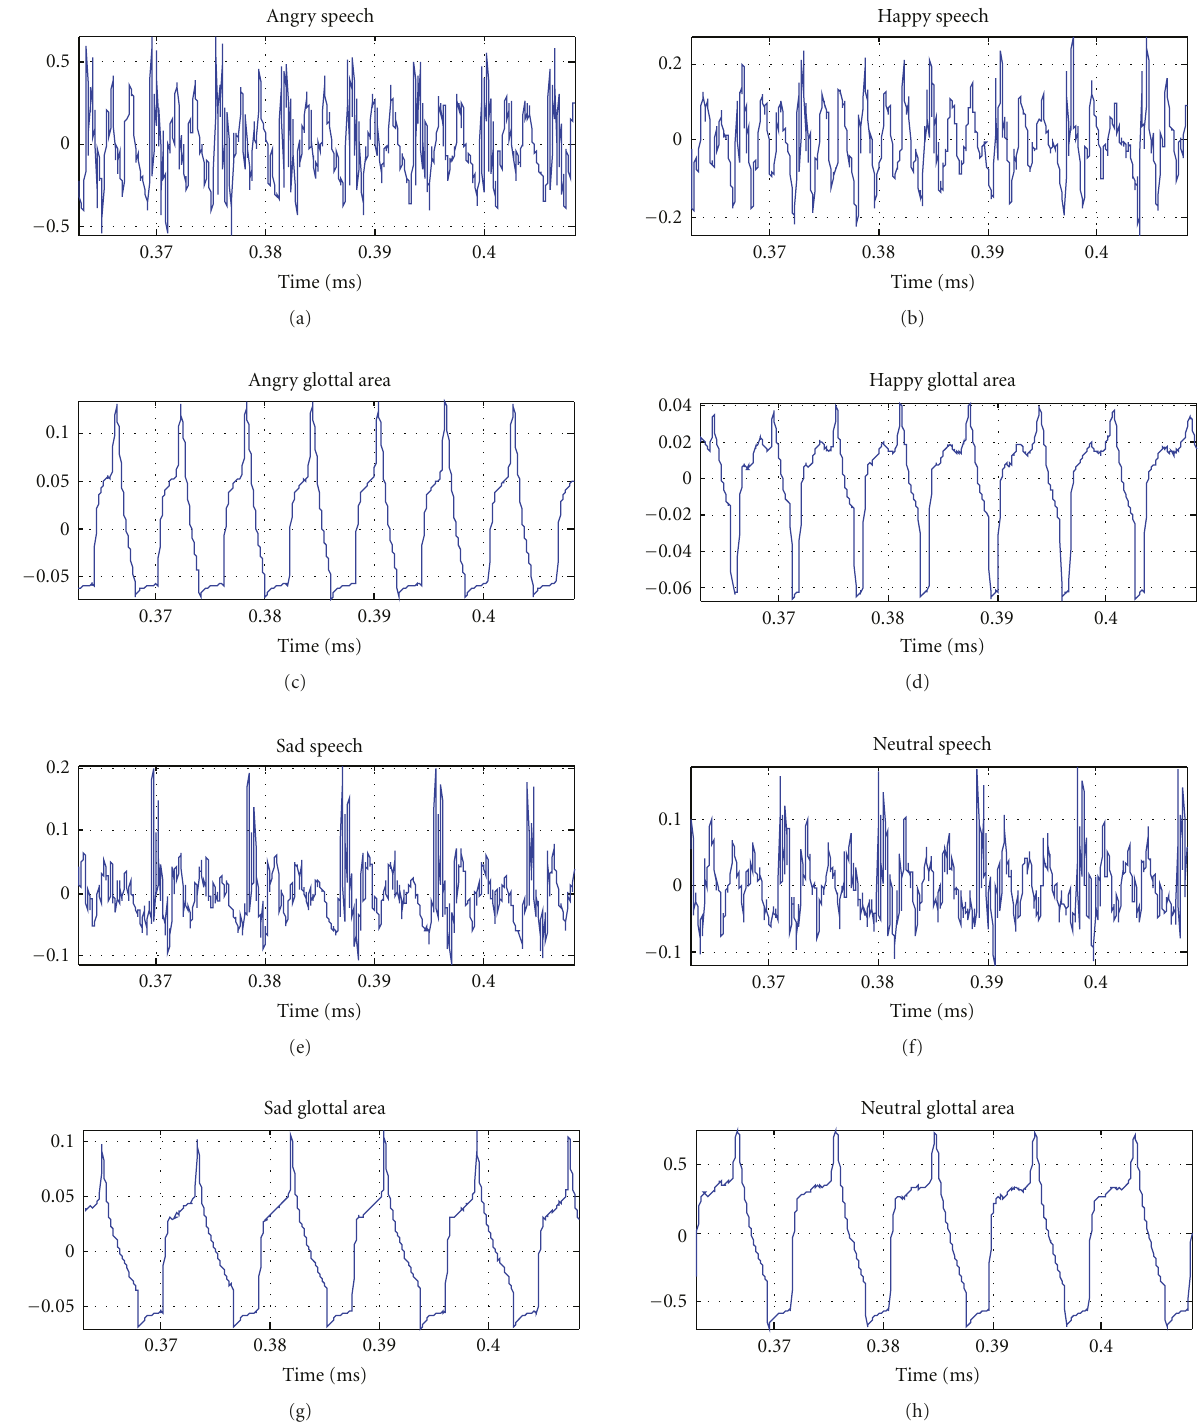
Figure 2: Speech and corresponding laryngograph-obtained glottal area waveforms for emotional speech.